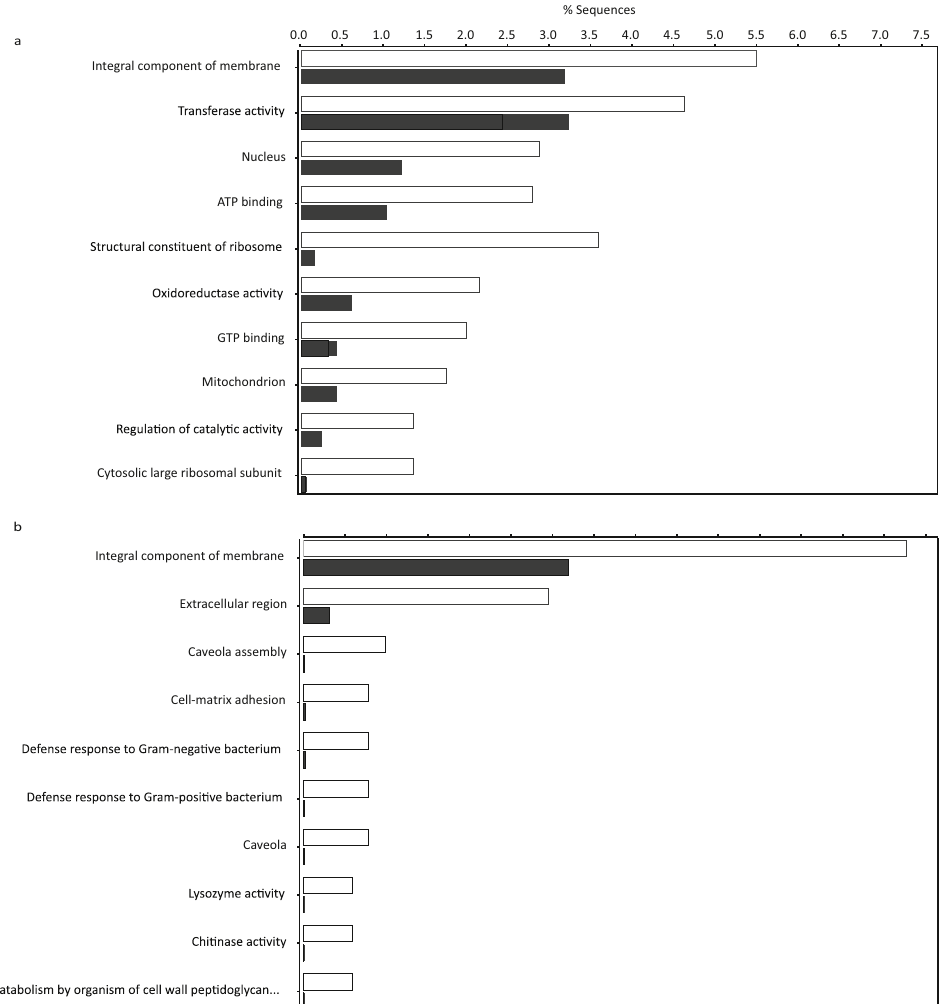
Figure 2. Over-represented Gene Ontology (GO) terms among ( a ) up-regulated and ( b ) down-regulated transcripts in mussels brought into captivity. White bars correspond to the transcriptome. Black bars correspond to the differentially expressed subset of